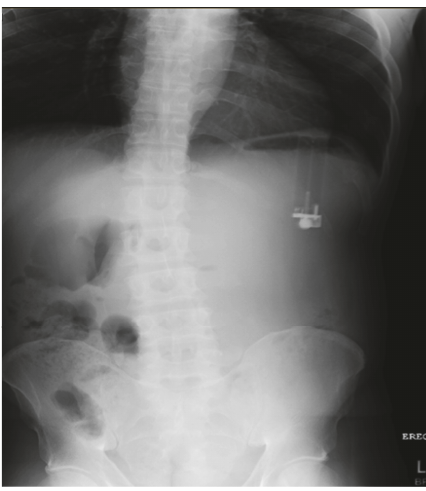
Figure 1: Cigarette lighter on abdominal X-ray.